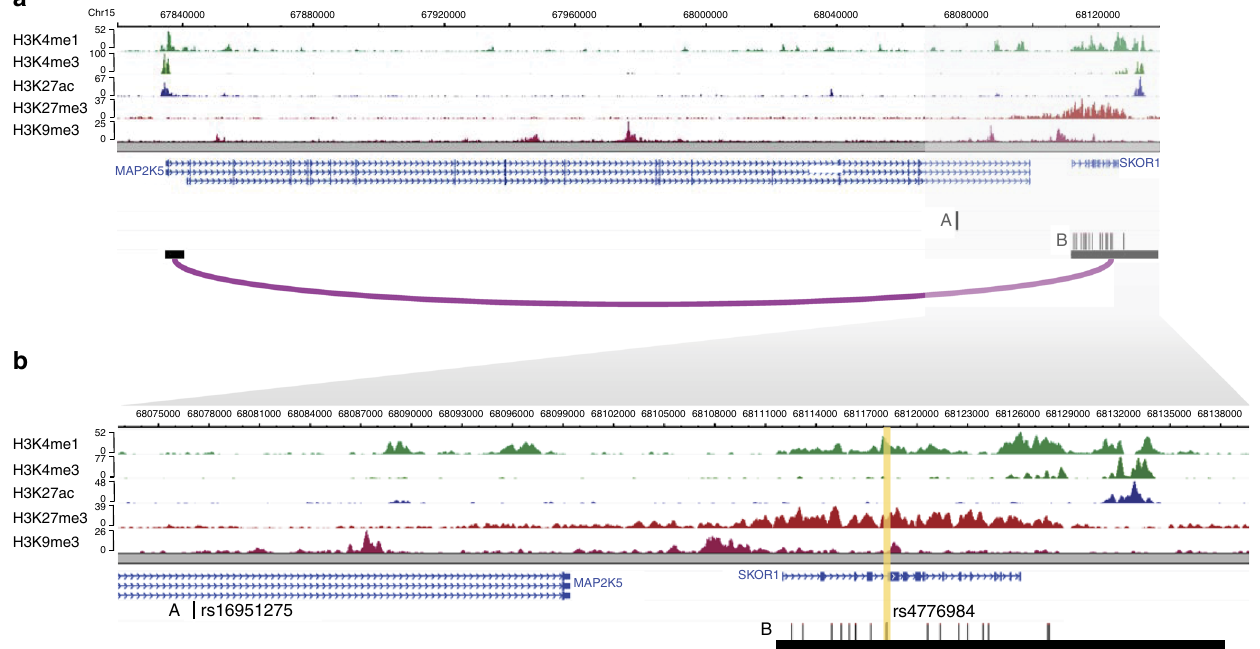
Fig. 3 Promoter Capture Hi – C enables re fi nement of the BMI GWAS locus that colocalizes with cis -eQTLs interacting with the target gene promoter of MAP2K5 . Genomic landscape of the BMI locus, MAP2K5 (panels a , b ), modi fi ed from the WashU Genome Browser to show the histone mark calls from ChIP-seq data; gene transcripts; promoter and eQTL Hind III fragments that interact in primary human white adipocytes (HWA); and GWAS SNPs (A, the rs number indicated in the magni fi ed box) or their LD proxies (B, r 2 > 0.8) located in the interacting Hind III fragment. The vertical yellow band highlights the cis -eQTL variant (the rs number is indicated in the magni fi ed box). a Genomic landscape containing MAP2K5 and the interacting cis -eQTL variant and corresponding BMI GWAS SNP. b Magni fi cation of the boxed region in ( a